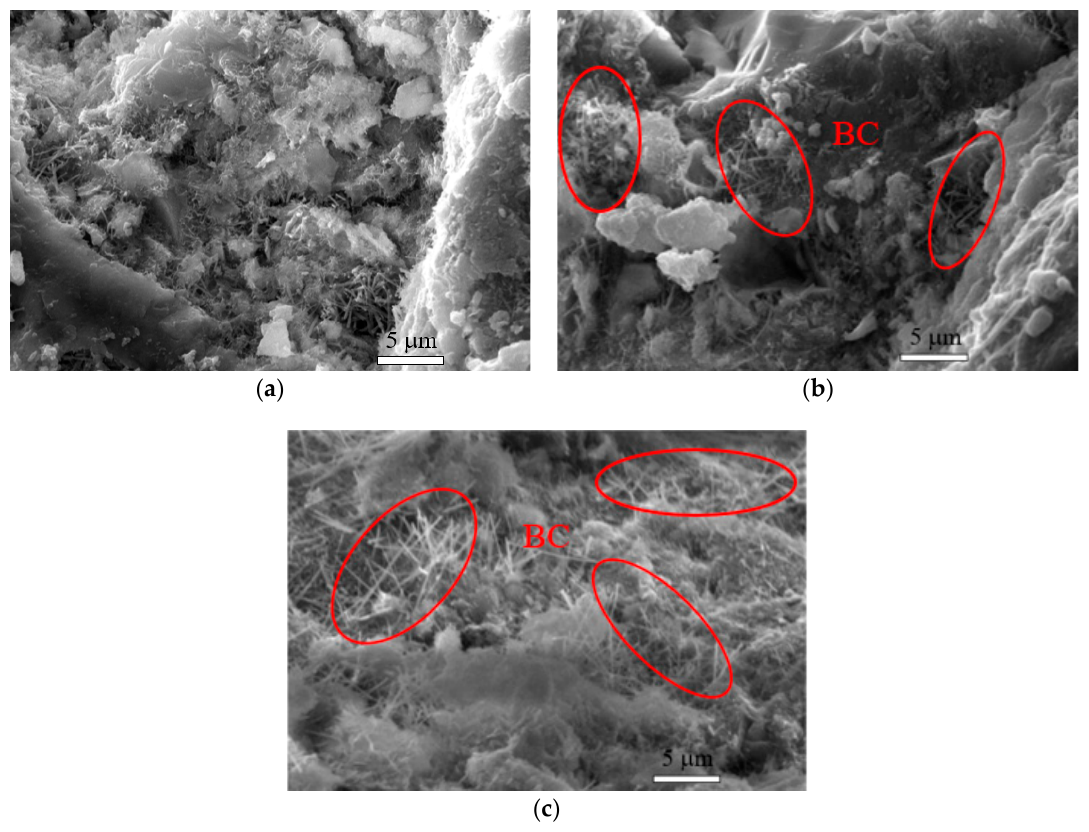
Figure 9. SEM images of ( a ) control specimen, ( b ) mortar with BC powder, and ( c ) mortar with BC gel. Reproduced from [20], with permission from Elsevier, 2020.